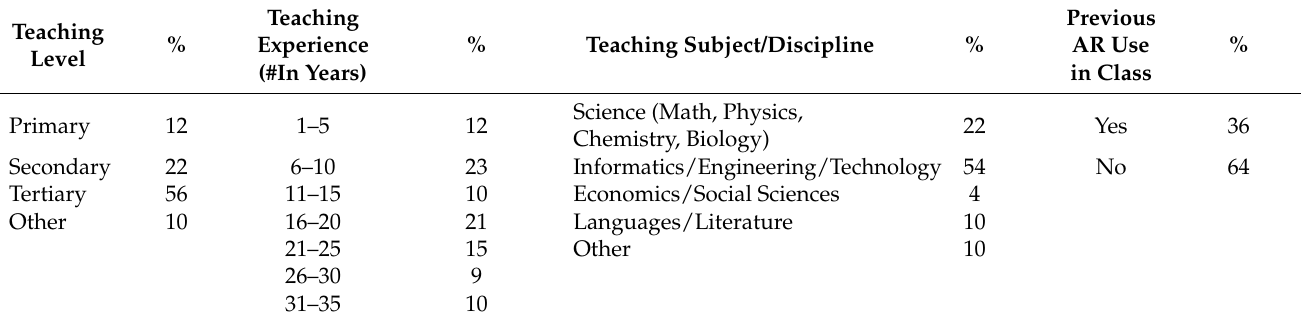
Table 2. Participants’ teaching related characteristics ( N =